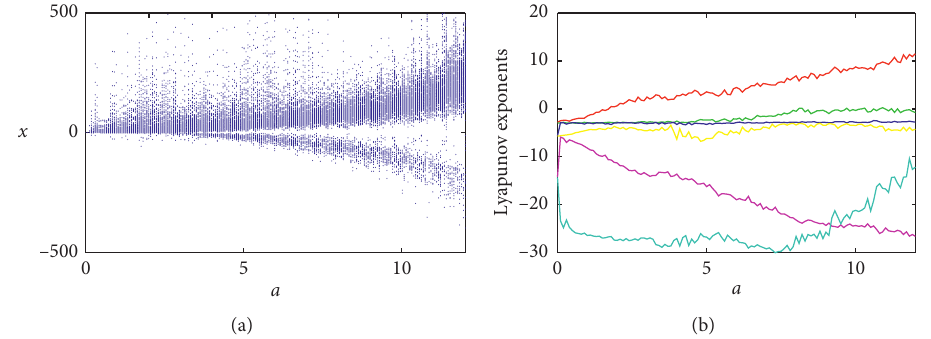
Figure 2: Lyapunov exponent spectrum and bifurcation diagram for parameter a ∈ [ 0 , 12 ] : (a) bifurcation diagram; (b) Lyapunov exponent